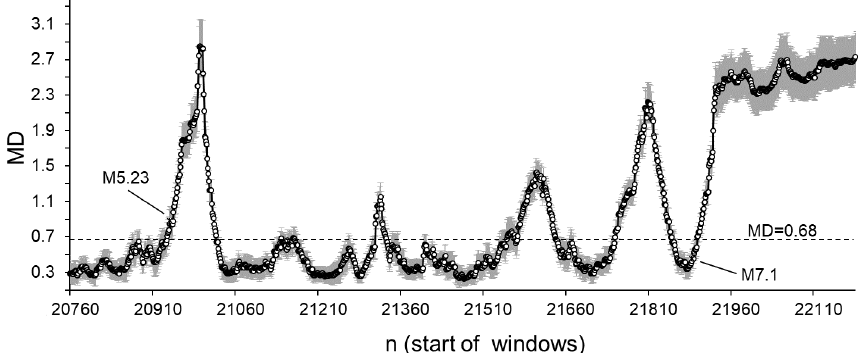
Figure 8. Average MD values calculated for the period from 24 August 1997 (20760) to 16 October 1999 (21160) in which two strong earthquakes occurred: M 5 . 23 (6 March 1998) and M 7 . 1 (16 October 1999). The MDs are calculated by comparing ICT( i ), ICD( i ), and ICE( i ) sequences from the original SC catalogue and from the set of randomised catalogues. The dotted line corresponds to a significant difference between the windows at p = 0 . 01. MD values are calculated for 50-data windows shifted by one data step.